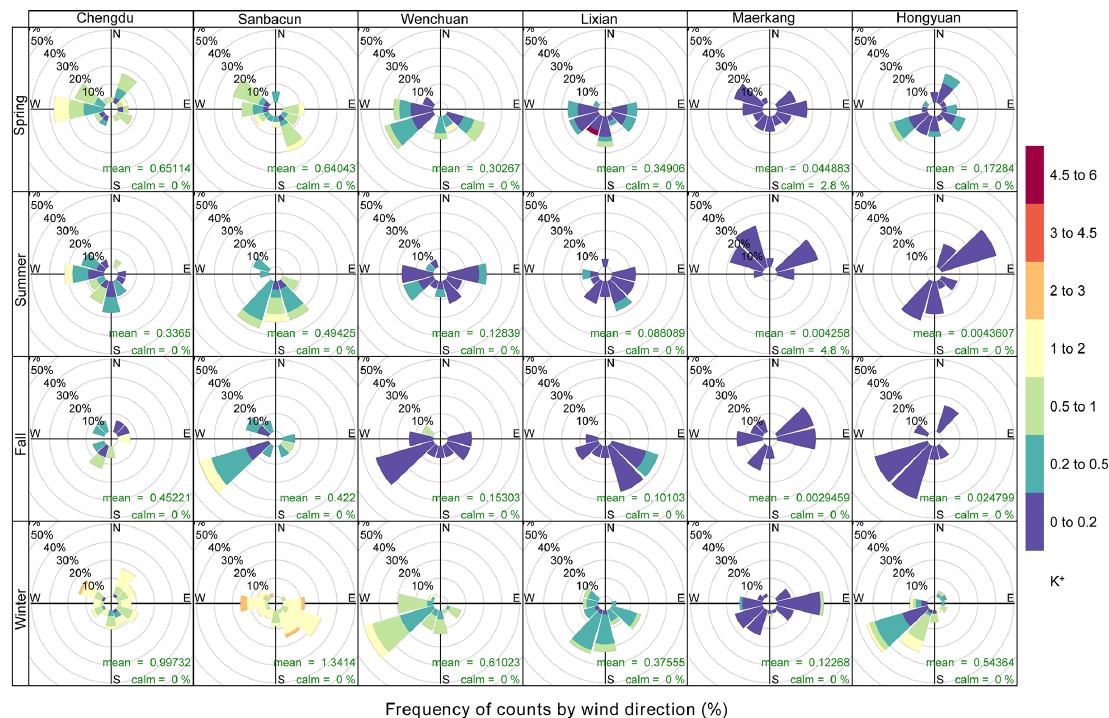
Figure 10. K + pollution rose in the four seasons at the six sites along the ESTP. Mean K + concentrations and calm frequencies also were given in each